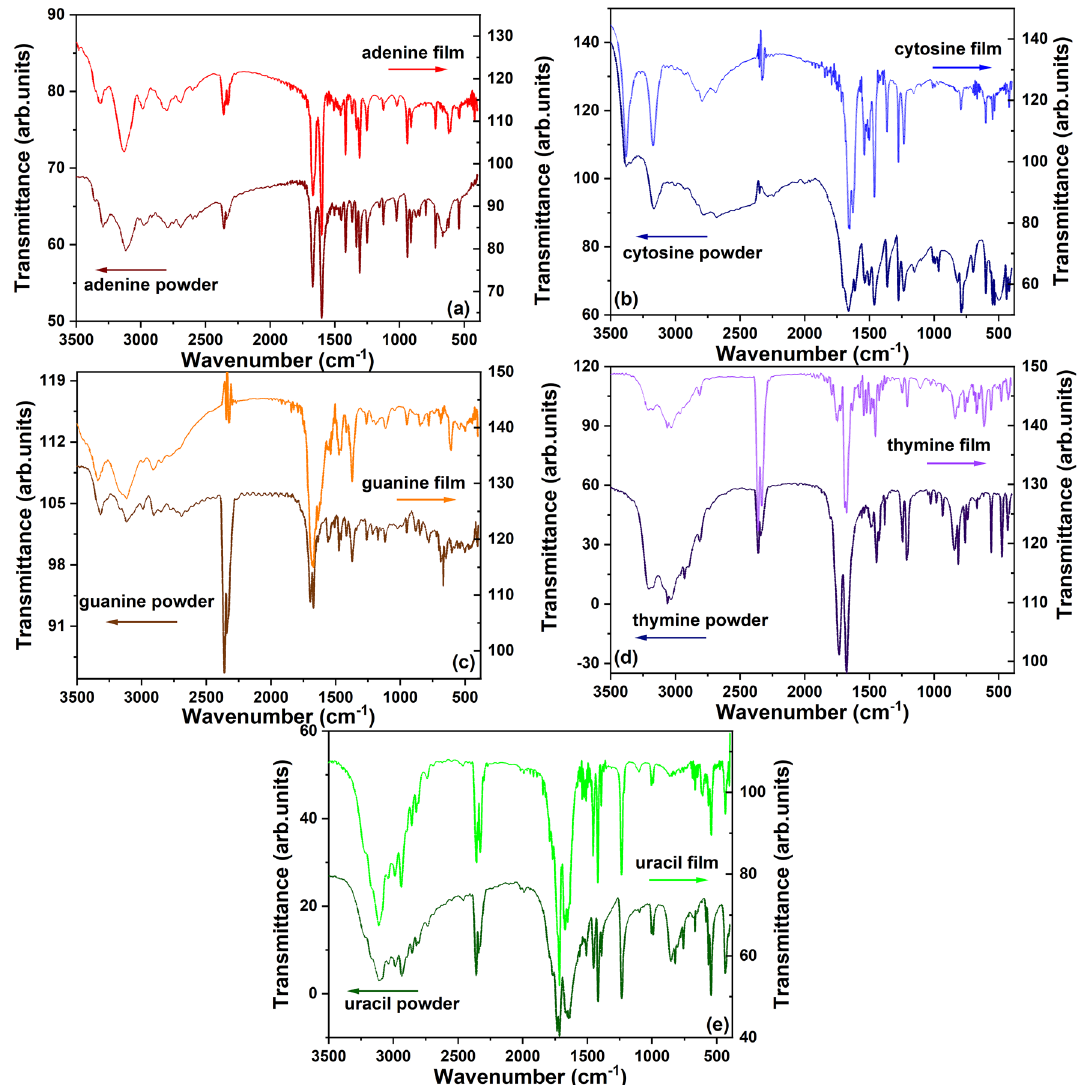
Figure 2. FTIR spectra of raw nucleobase powders and nucleobases thin films deposited by VTE on silicon (Fig. 2e), the characteristic vibrations can be noted at about: 758 cm −1 (C=O bending), 818 cm −1 (C-H bending), 1004 cm −1 and 1232 cm −1 (aromatic ring), 1417 cm −1 (N–H stretching), 1670 cm −1 (C=C stretching), 1716 cm −1 (C=O stretching), 1737 cm −1 and 1771 cm −1 (C=O out of plane deformation coupled with C=O stretching) 44,46 . Therefore, the FTIR results sustain that no chemical deterioration of nucleobases (adenine, cytosine, guanine, thymine and uracil) took place during their deposition by VTE, which is thus confirmed as a very adequate method for the preparation of thin films from these bio-organic compounds. The surface morphology of the vacuum deposited nucleobases thin films determined by the electrode surface flat or nanostructured, is important for their optical and electrical transport properties. Thus, it can be observed (Fig. 3) that the ITO layer deposited on flat glass substrate presents a smooth surface, while the one deposited on the nano-patterned glass substrate preserves the nanopillars developed in the photoresist layer. This means that there is a difference between the height of the pillars with ITO deposited on top and the height of the ITO deposited in the pitches, the space between pillars not being completely filled. Thus, the transmission of the ITO layer deposited over the periodic structures is affected by the reflectance at the interface ITO/air, the nano- patterning determining changes in the effective refractive index. Further, the morphology of the organic thin films deposited on flat and nanostructured ITO/glass substrates (Fig. 4) were analysed. For all nucleobases, the SEM images reveal continuous layers with morphologies show- ing various types of grains depending on the particularities of each nucleobase (Fig. 4a–e). The films of adenine and uracil show grains with random orientation well-packed, having larger dimension and elongated shape in the case of uracil. By comparison, the film of thymine shows grains of different shape (including splinters) and dimension, randomly distributed in the layer. The presence of the nanopillars induces some changes on